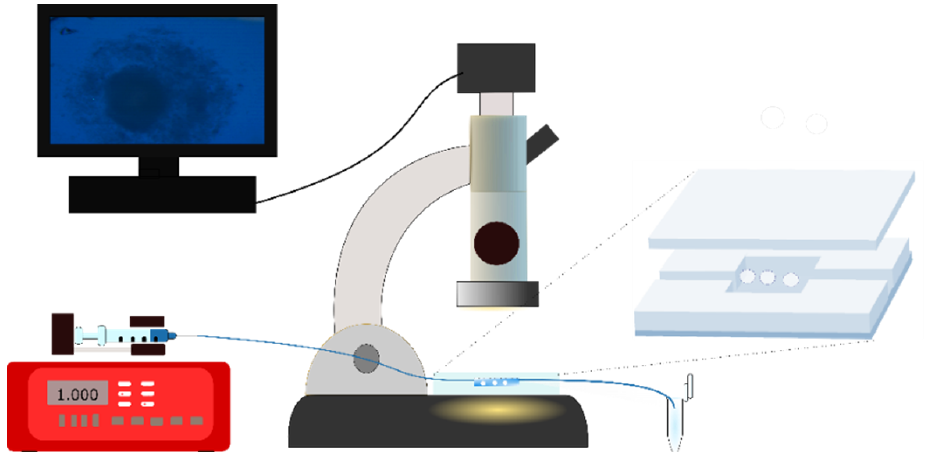
Figure 8. Experimental setup for pellet disintegration/dissolution test: (Microfluidic dissolution tester by Laki Technology (BioMicrofluidicsLab PPKE ITK), Pump (KF Technology, NE1000) Flow: 4000 μ L/h, Nikon SMZ 1000 Optics 1×, Magn: 3×; NIS Elements Imaging Software).